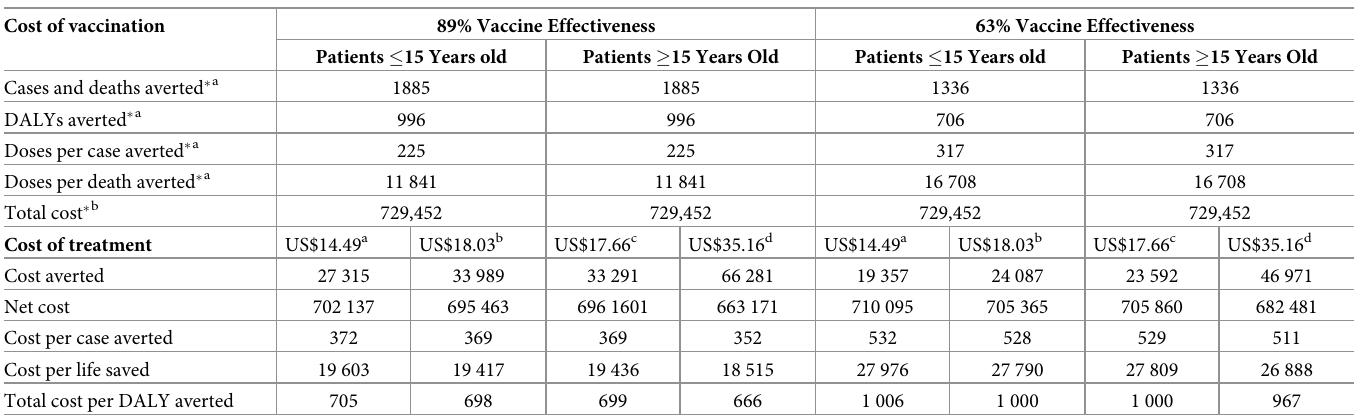
Table 7. Base-case estimates for cost-effectiveness of vaccination with single dose of